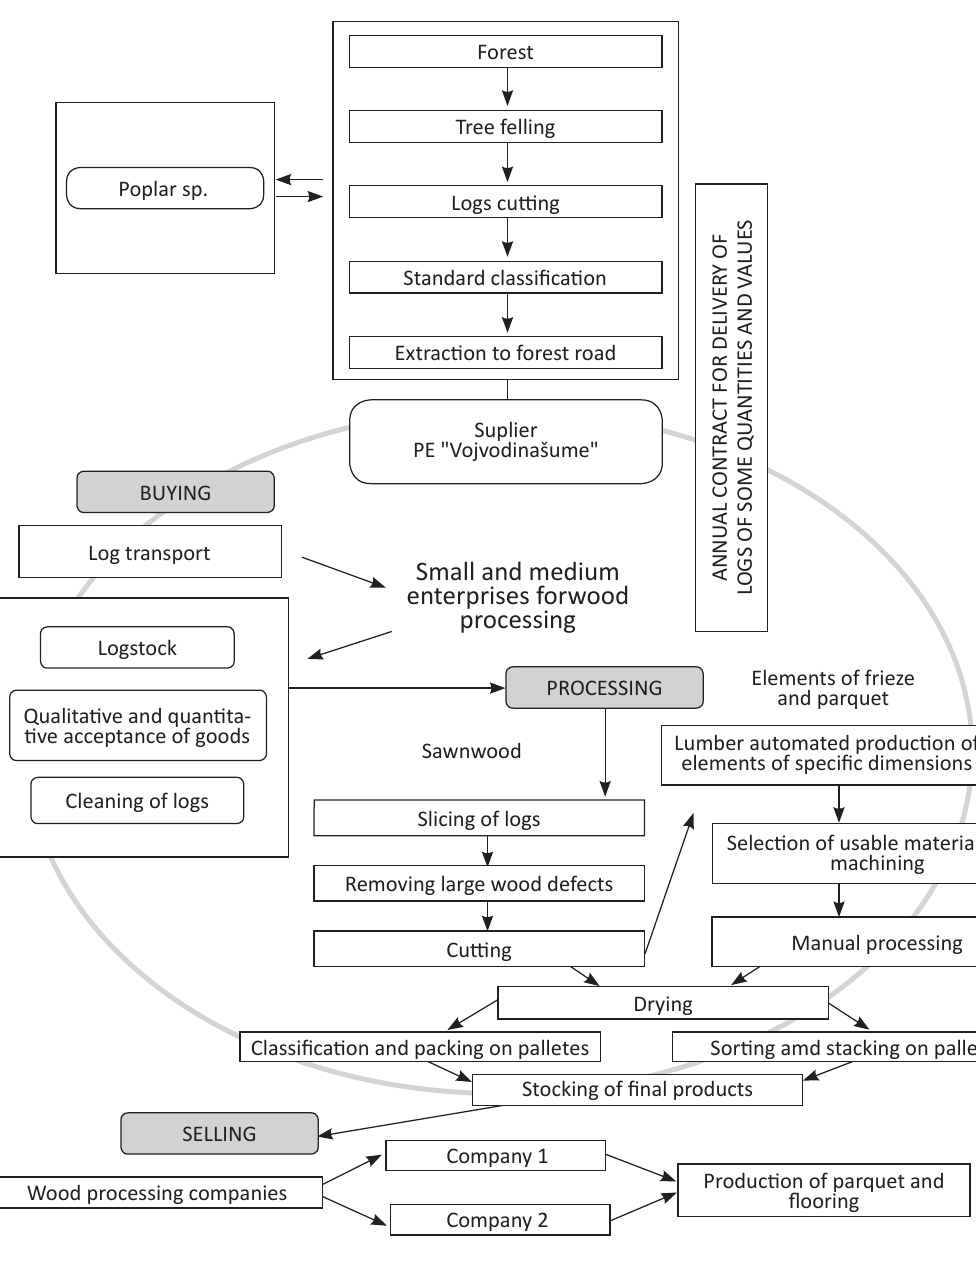
FiGURe 3. Supply chain in poplar wood production (Source: Marčeta M. (unpublished), adapted by Keča